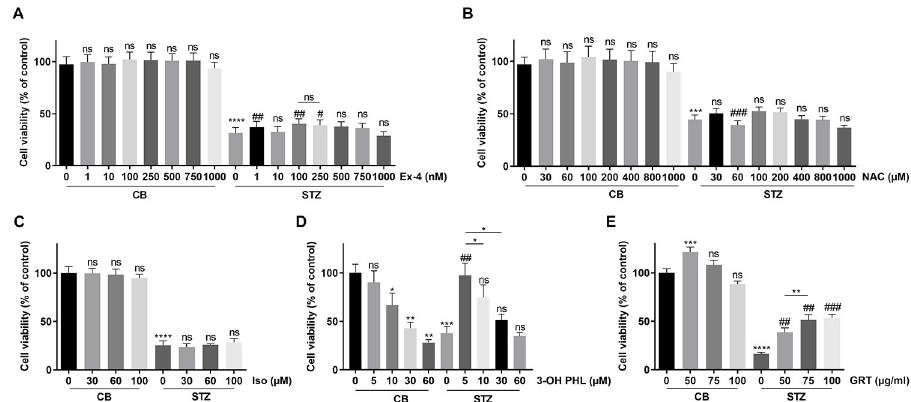
Fig 1. Cytoprotective effect of flavonoid treatment or reference molecules on INS1E β cells after 1.5 mM STZ exposure. INS1E cells were cultured in 96-well plates. Cells were treated with (A) Exendin-4 (Ex-4), (B) N- acetylcystein (NAC), (C) isoorientin (Iso), (D) 3-hydroxyphloretin (3-OH PHL) and (E) GRT, at indicated concentrations 24 h prior to STZ insult and at the time of STZ insult. STZ controls received citrate buffer (CB). After STZ insult, the medium was replaced by fresh medium containing the respective compounds. 18 h after STZ insult, cell viability was measured using MTS assay. Results represent average of independent plates ± SEM. Exendin-4 (n = 15), NAC (n = 9), isoorientin (n = 3), 3-OH PHL (n = 6) and GRT (n = 6). Differences between groups were analysed by paired One-way ANOVA with Sidak’s multiple comparisons test. � above bars indicate comparison against control. # above bars indicate comparison against STZ. � above lines indicate comparison between two treatment groups. Non- significant results are indicated by ns. � p < 0.05, �� p < 0.01, ��� p < 0.001, ���� p < 0.0001, #p < 0.05, ##p < 0.01 and ###p <